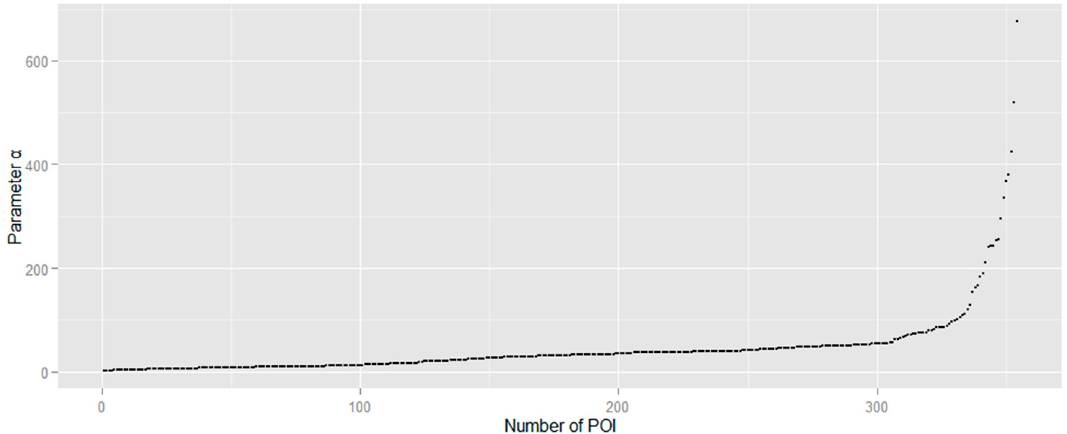
Figure 9. Distributions of parameter α in one POI cluster.